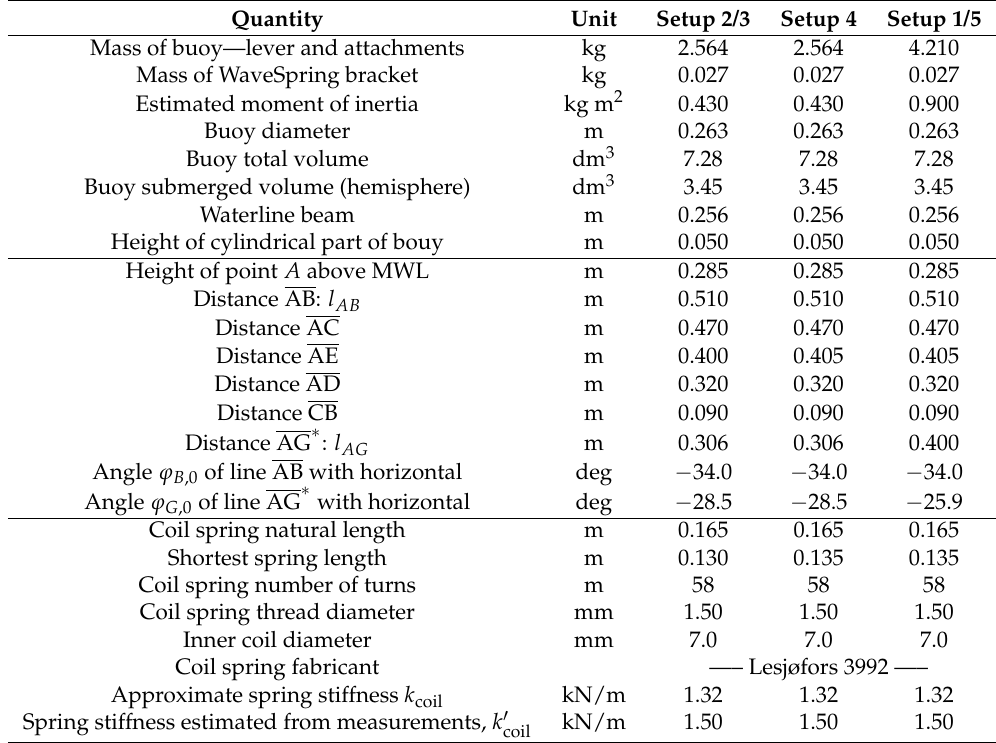
Table 1. Constant physical properties of the experimental setup. Distances refer to Figure